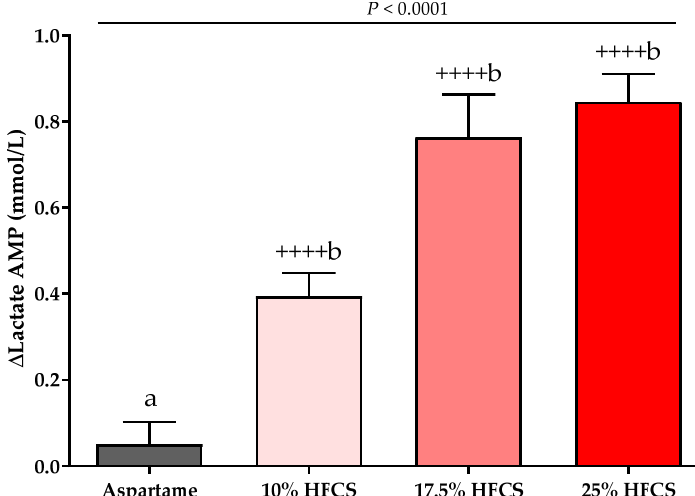
Figure 7. Changes in lactate amplitudes (AMP): Mean ± SEM of the absolute change (intervention − baseline) in lactate amplitudes in participants consuming 0 ( n = 23), 10 ( n = 18), 17.5 ( n = 15), or 25% ( n = 28) HFCS-sweetened beverages for the two-week intervention. p = the effect of SB group, two-factor (HFCS group, sex) ANCOVA with adjustment for MSRF and outcome at baseline; ++++ p < 0.0001, LS mean different from zero; a different from b, Tukey’s.